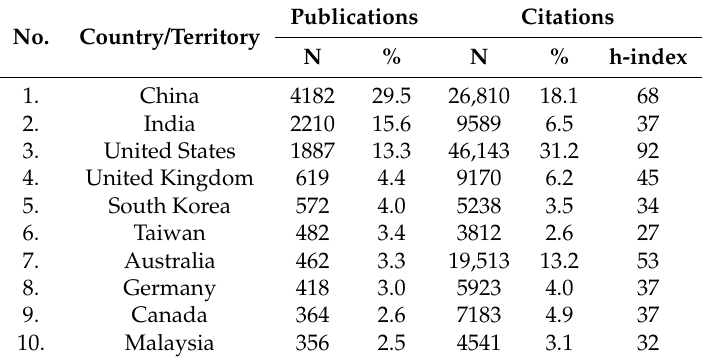
Table 1. Most productive countries/territories in research on cloud